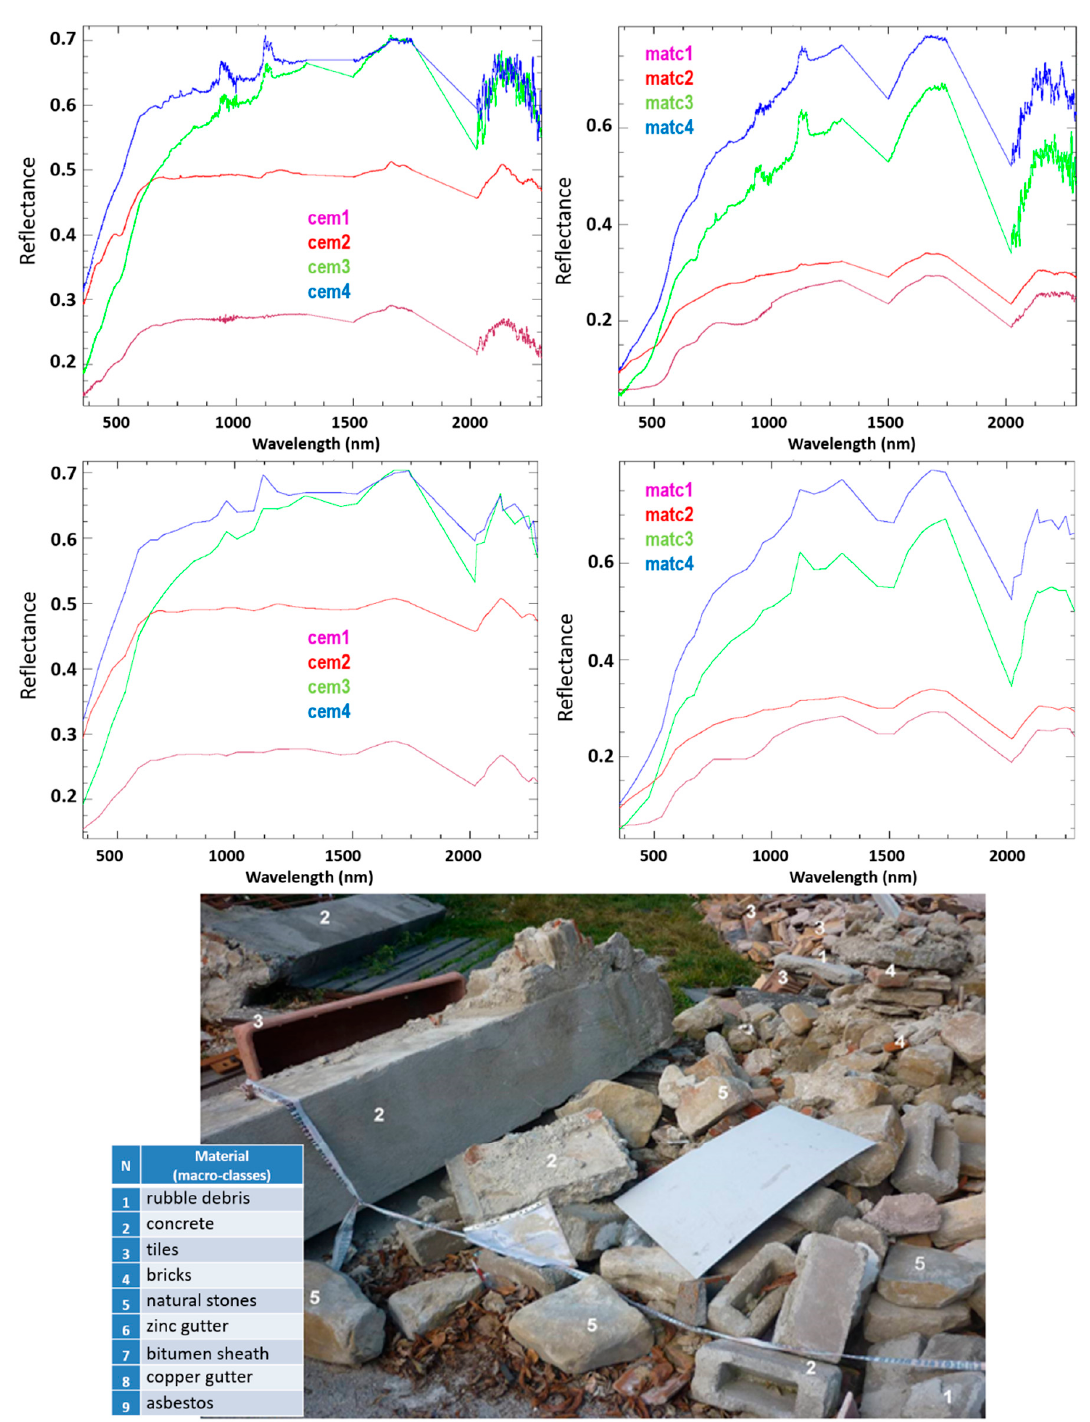
Figure 3. In situ hyperspectral signatures of concrete ( top left ) and brick ( top right ) after the first pre-processing phase but before smoothing by filtering and corresponding filtered spectral signatures of the concrete ( lower left ) and brick ( lower right ) categories. In the bottom image some samples of the eight types of rubble materials (white numbers to be matched with the legend on the left lower corner of the image) are displayed.